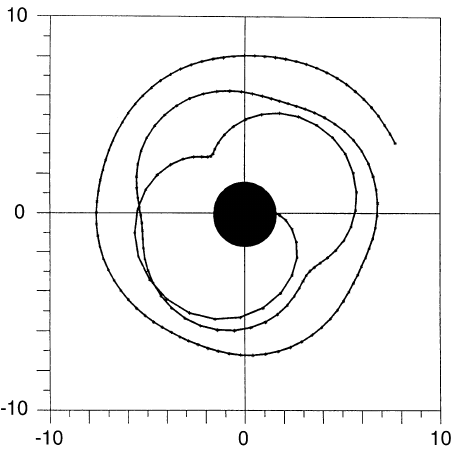
Fig. 4. Lagrangian particle trajectory at the initial and intermediate stages is shown in the polar co-ordinate system. Trajectory is computed from Eq. (8) for a value of the friction parameter Fig. 5. Down slope specific flux, q s , as a function of the bottom layer (cid:97) (cid:136) 0 : 05, a source radius s thickness, h , according to formula 1 (cid:136) 1 : 5 for the time interval 0 < t < 72